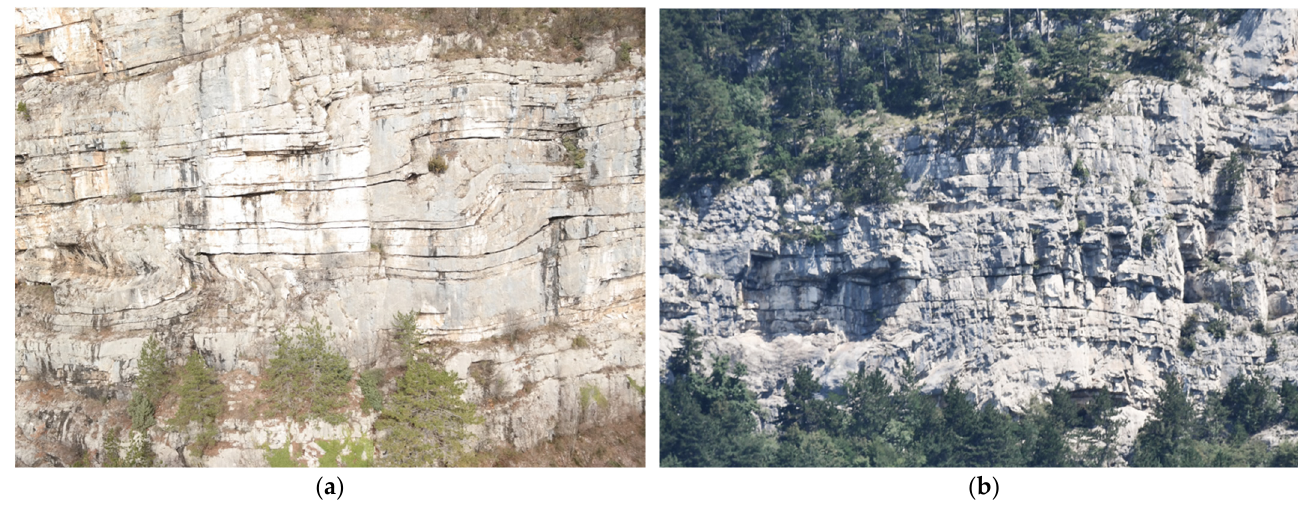
Figure 8. Folds identified at the Raspadalica Cliff face: ( a ) monocline type of fold (middle part) and horizontal inclined fold (left down) in in the eastern part (in Zones Z3 and Z4); ( b ) the remains of the anticline fold western part of the cliff, in area of zone Z2 in the lower part of the figure.